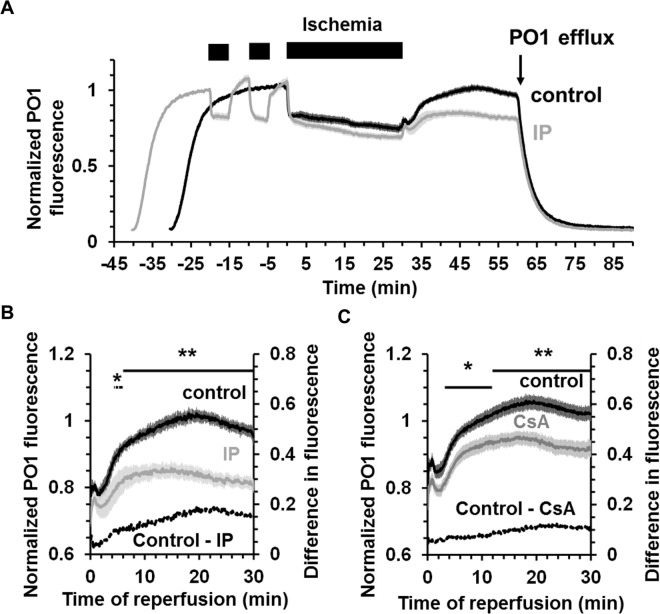
H2O2 production measured using PO1 fluorescence in control and IP hearts during ischemia / reperfusion.A, Averaged fluorescence data for control (black) or IP (grey) hearts perfused with 5 μmol/L PO1. PO1 was present in the perfusion solution from 30 min (Control) or 40 min (IP) before starting global ischemia. PO1 was excluded from the perfusion solution after 30 min of reperfusion. The fluorescence was normalized using the value obtained at -11 min for control and -21 min for IP hearts and then averaged for each group. B, Mean data (± SEM as error bars; n = 11 for control and n = 9 for IP hearts) for PO1 fluorescence during the reperfusion period. C, Mean data (± SEM as error bars; n = 17 for control and n = 16 for CsA-treated hearts) for PO1 fluorescence during reperfusion of control hearts (black) and CsA-treated hearts (grey). Data were normalized to the fluorescence value at -16 min. Where present, CsA (0.2 mmol/L) was added to the PO1 perfusion solution 15 min before ischemia and during 30 min of reperfusion. Statistically significant effects of IP and CsA are shown by the horizontal lines (* p ≤ 0.05; ** p ≤ 0.01). Corresponding infarct sizes are presented in Table 1.